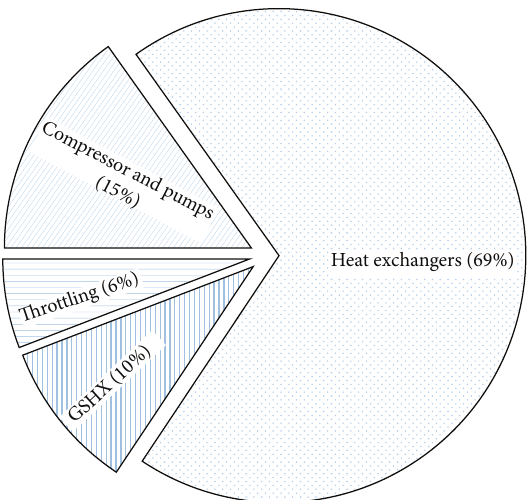
Figure 8: Sustainability index of the GSHP and PV systems during